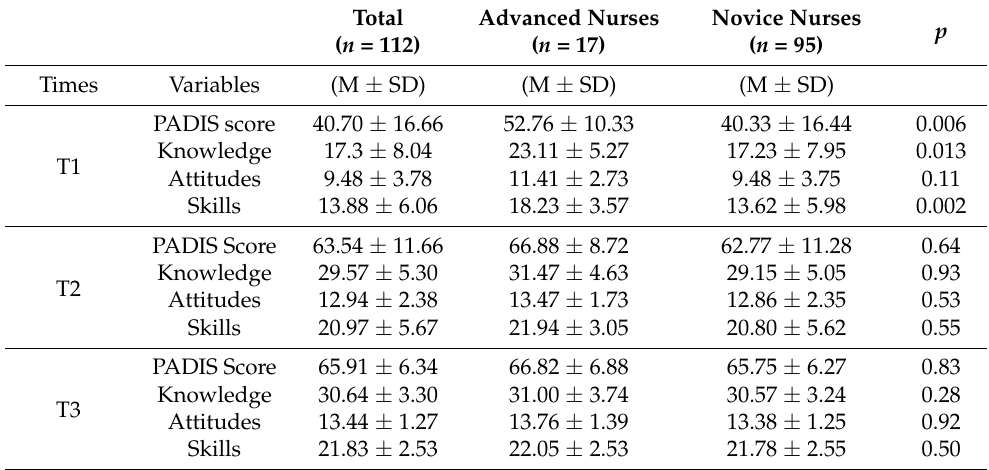
Table 3. Comparison of the differences between novice and advanced nurses at each time point.